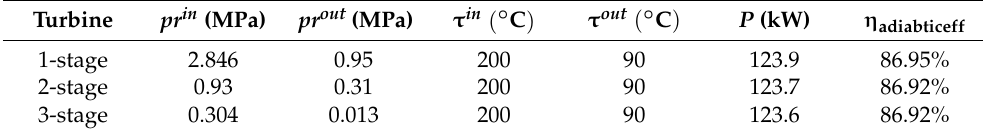
Table 3. The parameters of the turbine under design operation.